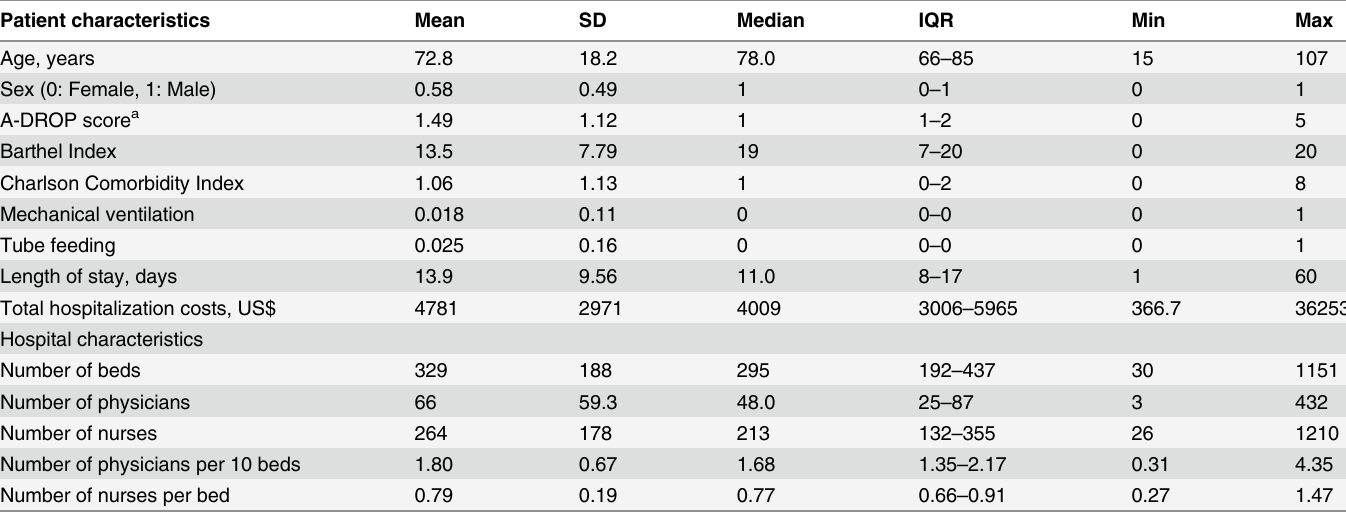
Table 1. Characteristics of 30,041 pneumonia patients and 289